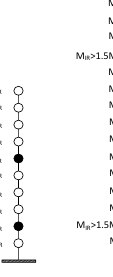
Figure 1. Mas irregularity positions in the simulated buildings.